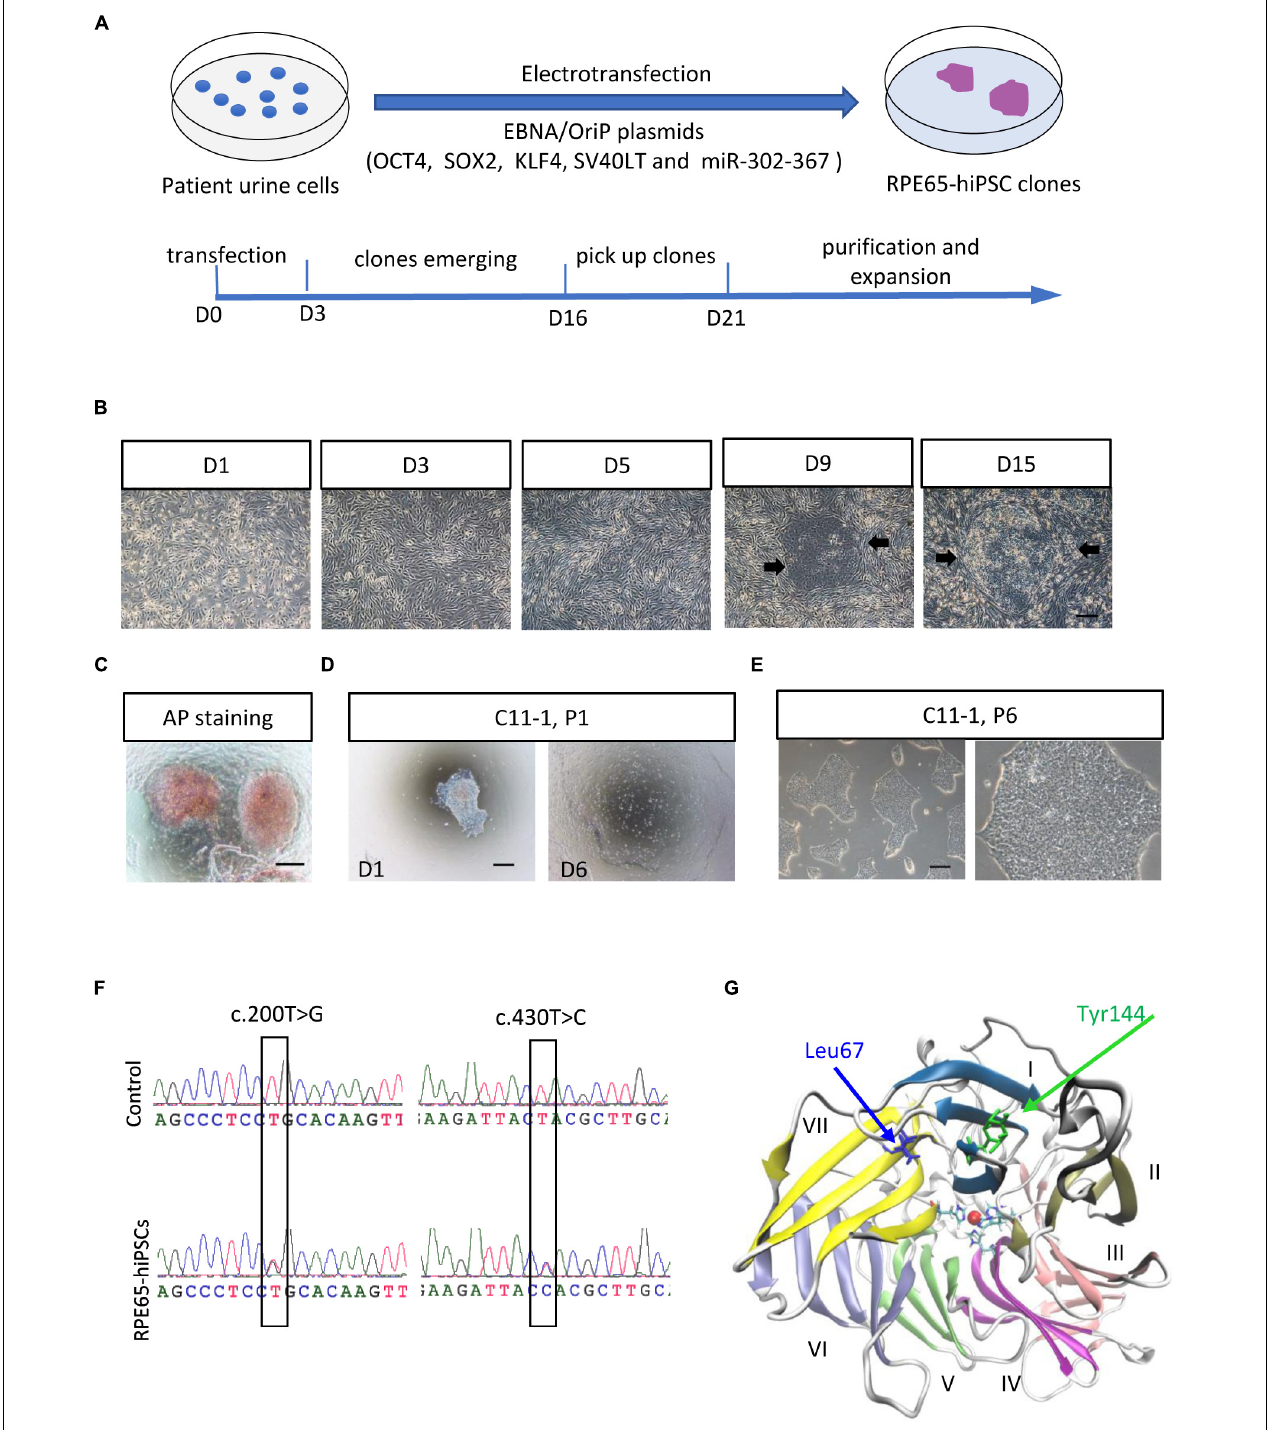
FIGURE 1 | Generation and amplification of RPE65-hiPSCs. (A) Schematic overview of generating integration-free RPE65-hiPSCs from UCs. (B) Progressive formation of RPE65-hiPSCs colonies after UCs reprogrammed. The black arrows showed emerging clones. (C) The emerging clones were positive for AP staining. (D) A manually picked small clump from primary clone gradually formed typical clones on D6. (E) Passaged RPE65-hiPSCs clones with EDTA treatment. Scale bars, 250 µ m. (F) Sanger sequencing confirmed hiPSCs from the LCA patient contained compound RPE65 gene mutations with c.200T > G and c.430T > C. (G) Structure of human RPE65 monomer viewed from the bottom face of the seven-bladed β -propeller. Blades are numbered I–VII. Absolutely conserved His180, His241, His313, and His527 residues are shown as sticks coordinating the natively bound iron ion. The two mutation sites Leu67 (L67) and Tyr144 (Y144) are shown as blue and green sticks,